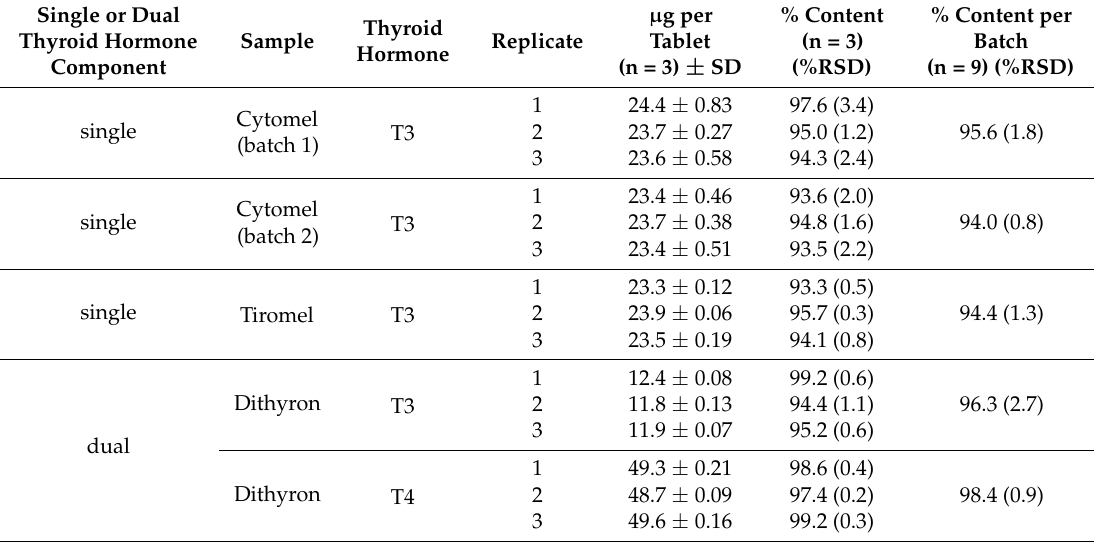
Table 2. Tablet analysis: single- and dual-component thyroid hormone